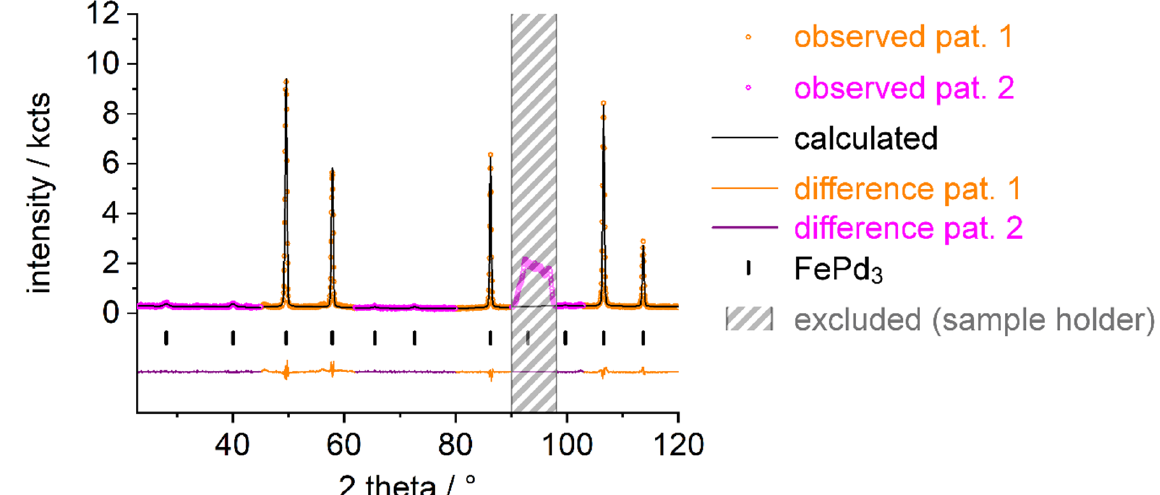
Figure A20. Rietveld refinement of the crystal structure of FePd 3 D 0.062(10) (for details, see eighth row in Tables A8 and A9) based on neutron powder diffraction data (NUMOR 131781 [21], λ = 186.80(2) pm, D20 ILL, Grenoble) in a single-crystal sapphire cell at 475(3) K and 8.21(1) MPa deuterium pressure using FullProf [24].